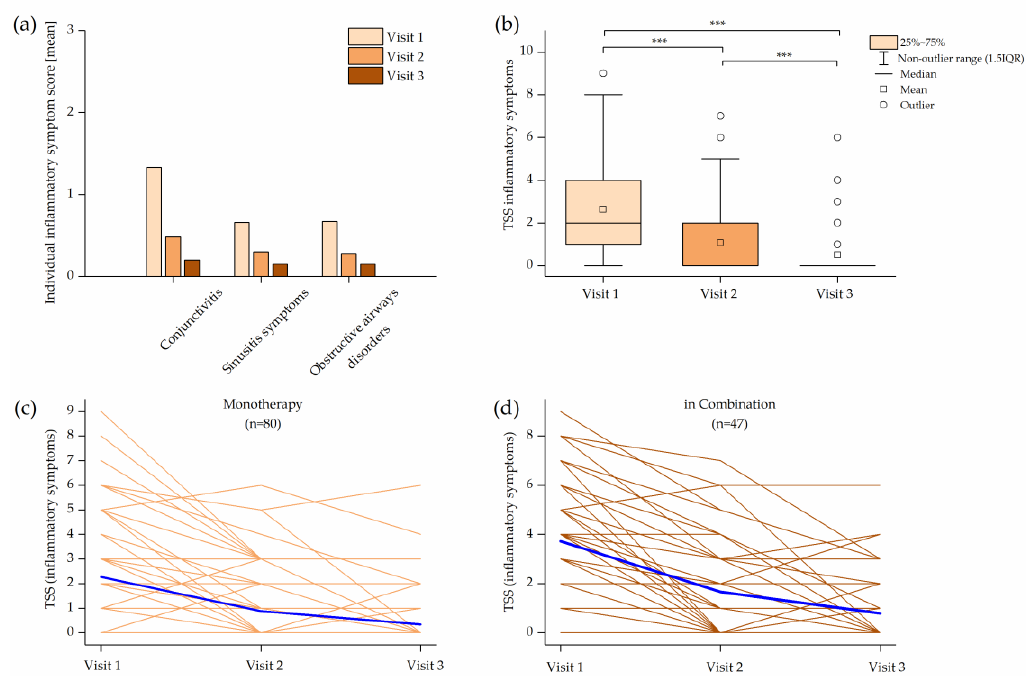
Figure 5. Effect of treatment over the treatment duration: ( a ) individual inflammatory symptoms for all symptom scores were mutually significant between the visits ( p < 0.01); ( b ) box plot of the inflammatory total symptom score (TSS); ( c ) time course of the individual inflammatory TSS values for subjects with Ze 339 monotherapy; ( d ) time course of the individual inflammatory TSS for subjects with concomitant therapy. Blue lines indicate the mean of the TSS.